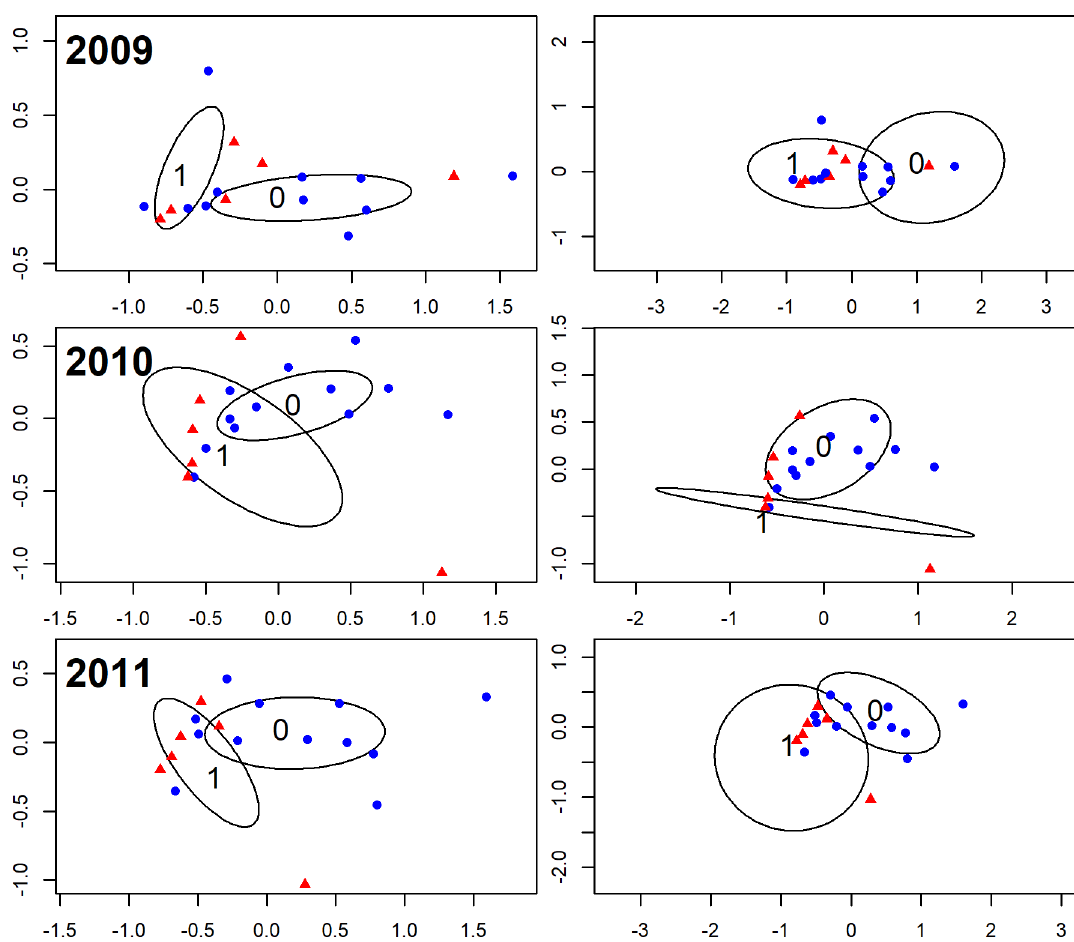
Fig 2. Results of the NMDS analyses for the three years, showing the dissimilarity in species composition between artificial and natural wetlands, based on the Bray-Curtis dissimilarity index, when presence/absence (left column) and abundances (right column) are used. Blue circles ( ● ) correspond to artificial wetlands and red triangles ( ▲ ) to natural